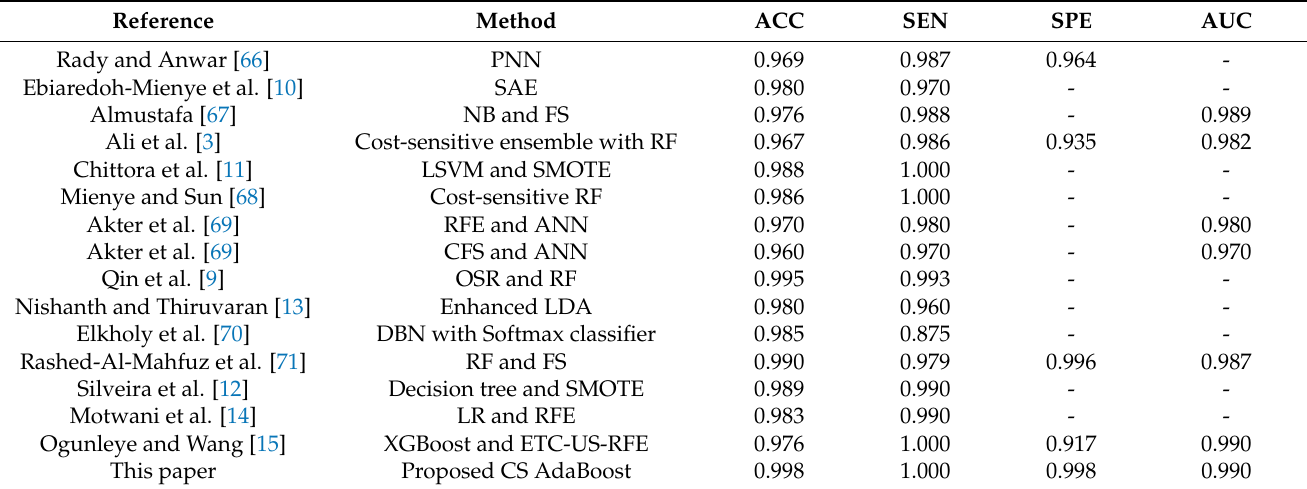
Table 5. Comparison with other